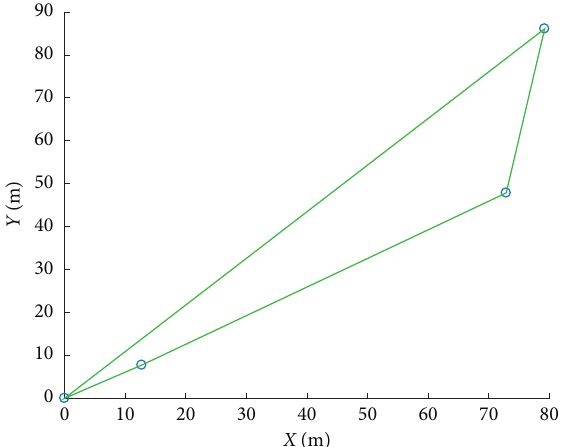
Figure 16: Planned trajectory at the beginning of the fourth subcycle.